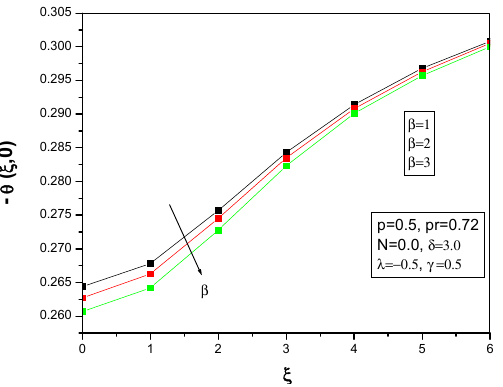
Figure 17. Effect of the magnetic field and buoyancy force parameter on the Nusselt number.